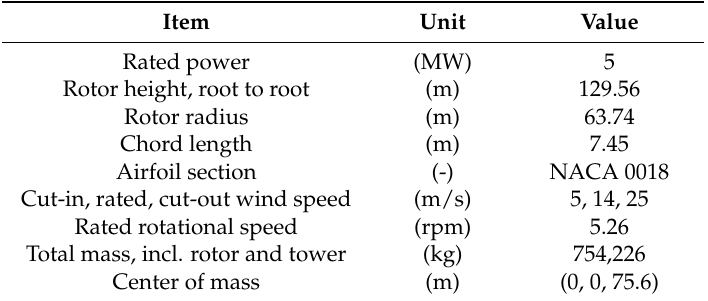
Figure 1. The diagram of the deep spar and short spar vertical-axis wind turbines (VAWTs) in deep and moderate water. Here MWL means mean water level. Table 1. Specifications of the Darrieus 5 MW wind turbine [13].